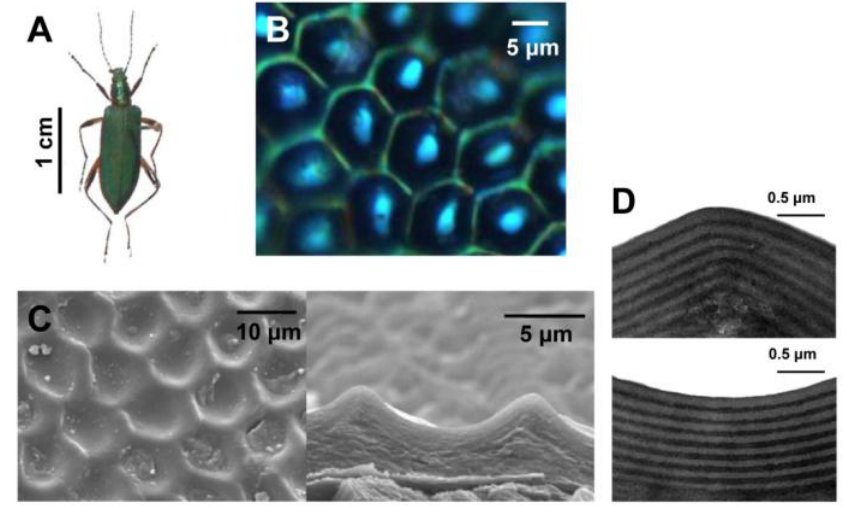
Figure 3. Naturally occurring composite multiscale photonic structures with variable structural colors. ( A ) The male Chlorophila obscuripennis beetle; its elytra displays an inconspicuous iridescent bluish green color. ( B ) Optical microscopic image of an elytron under 1,000 × magnification. It is composed of a framework composed of green hexagonal veins and a cyan center. ( C ) SEM images of top view (left) and transverse cross-section (right) of the outer elytral surface. The elytral surface comprises of an array of hexagonal pits. ( D ) TEM transverse cross section of the ridge (top) and basin regions (bottom) of the outermost elytra